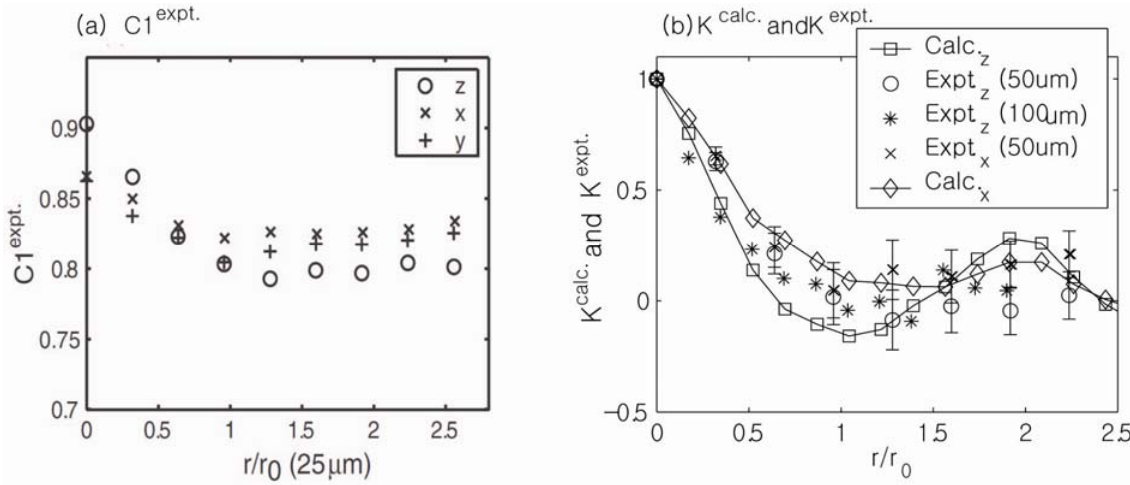
Figure 14. ( a ) Experimental measurements of the field correlation functions of a randomly packed sample of glass beads. Three independent measurements along the directions of external gradient are shown. The reduction in [ ] was strongest along the z -direction. ( b ) Comparisons of the experimental measurements with the numerical calculations. Reproduced from Reference [28] with